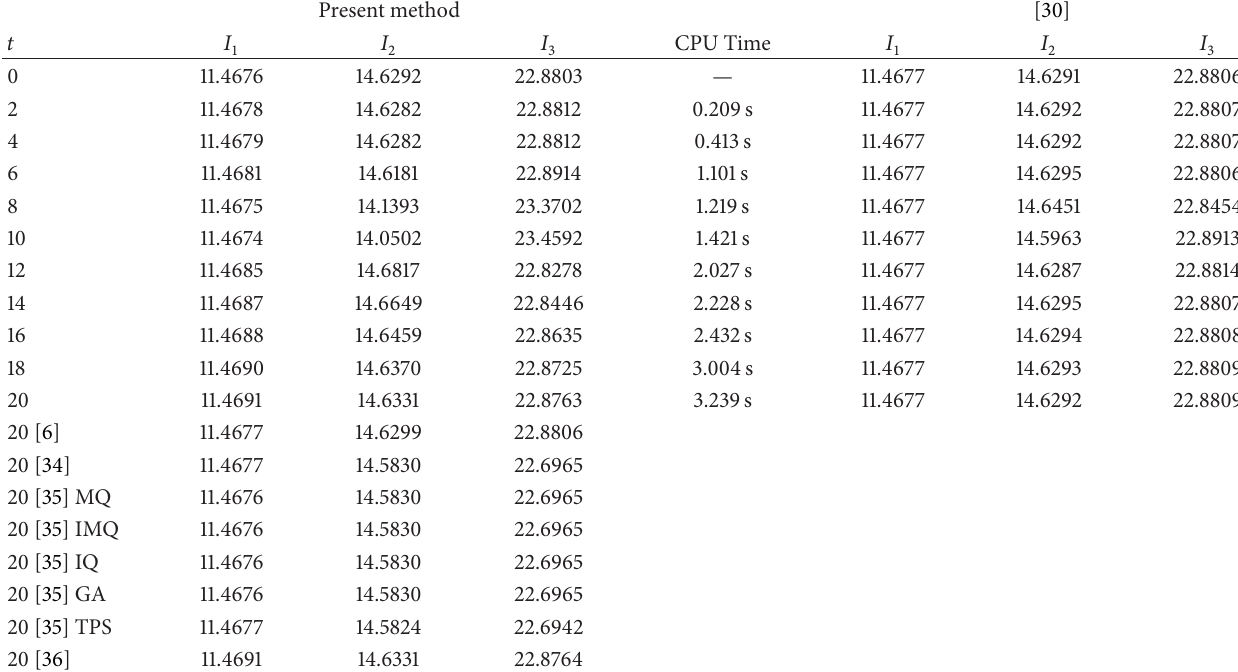
Table 6: Comparison of the invariants for the interaction of two solitary waves with results from [30] with ℎ = 0.2 , 𝑘 = 0.025 in the region 0 ≤ 𝑥 ≤ 250 . Present method